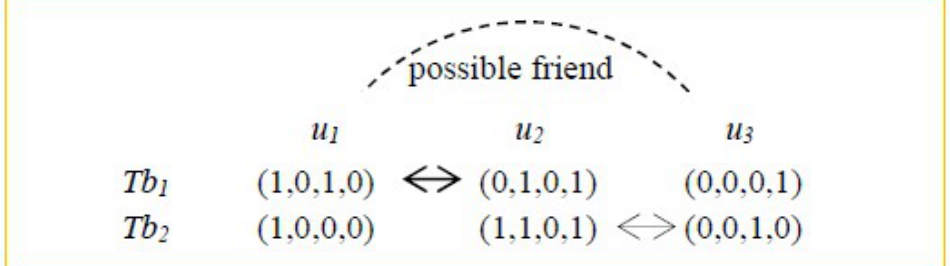
Figure 2. Indirect friend finding based on converse LSH: an example.